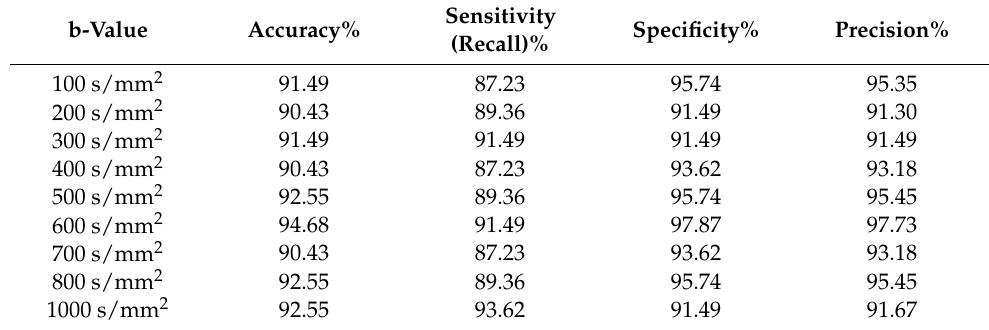
Table 7. Performance of VGGNet at 9 b-values using 94 randomly chosen ADC maps.